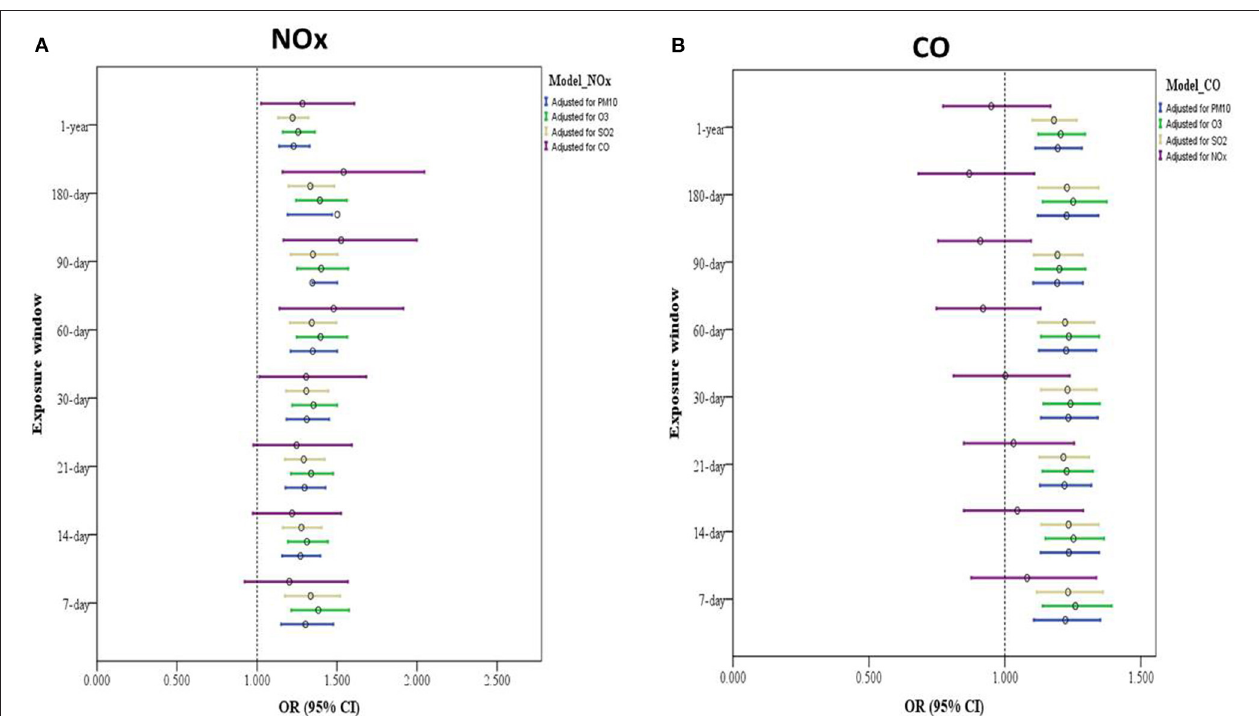
FIGURE 3 | Two-pollutant model of air pollution exposure and its association with depressive symptoms among older adults. (A) Model with adjustments for sex, age, educational attainment, marital status, financial status (self-reported), physical activity, alcohol intake, heart disease, IADL score, season of study visit, SPMSQ score, and exposure to other air pollutants (such as PM 10 , O 3 , CO, and SO 2 ). (B) Model adjusted for sex, marital status, age, educational attainment, financial status (self-reported), physical activity, alcohol intake, heart disease, IADL score, season of study visit, SPMSQ score, and exposure other air pollutants (e.g., NOx, PM 10 , O 3 , and SO 2